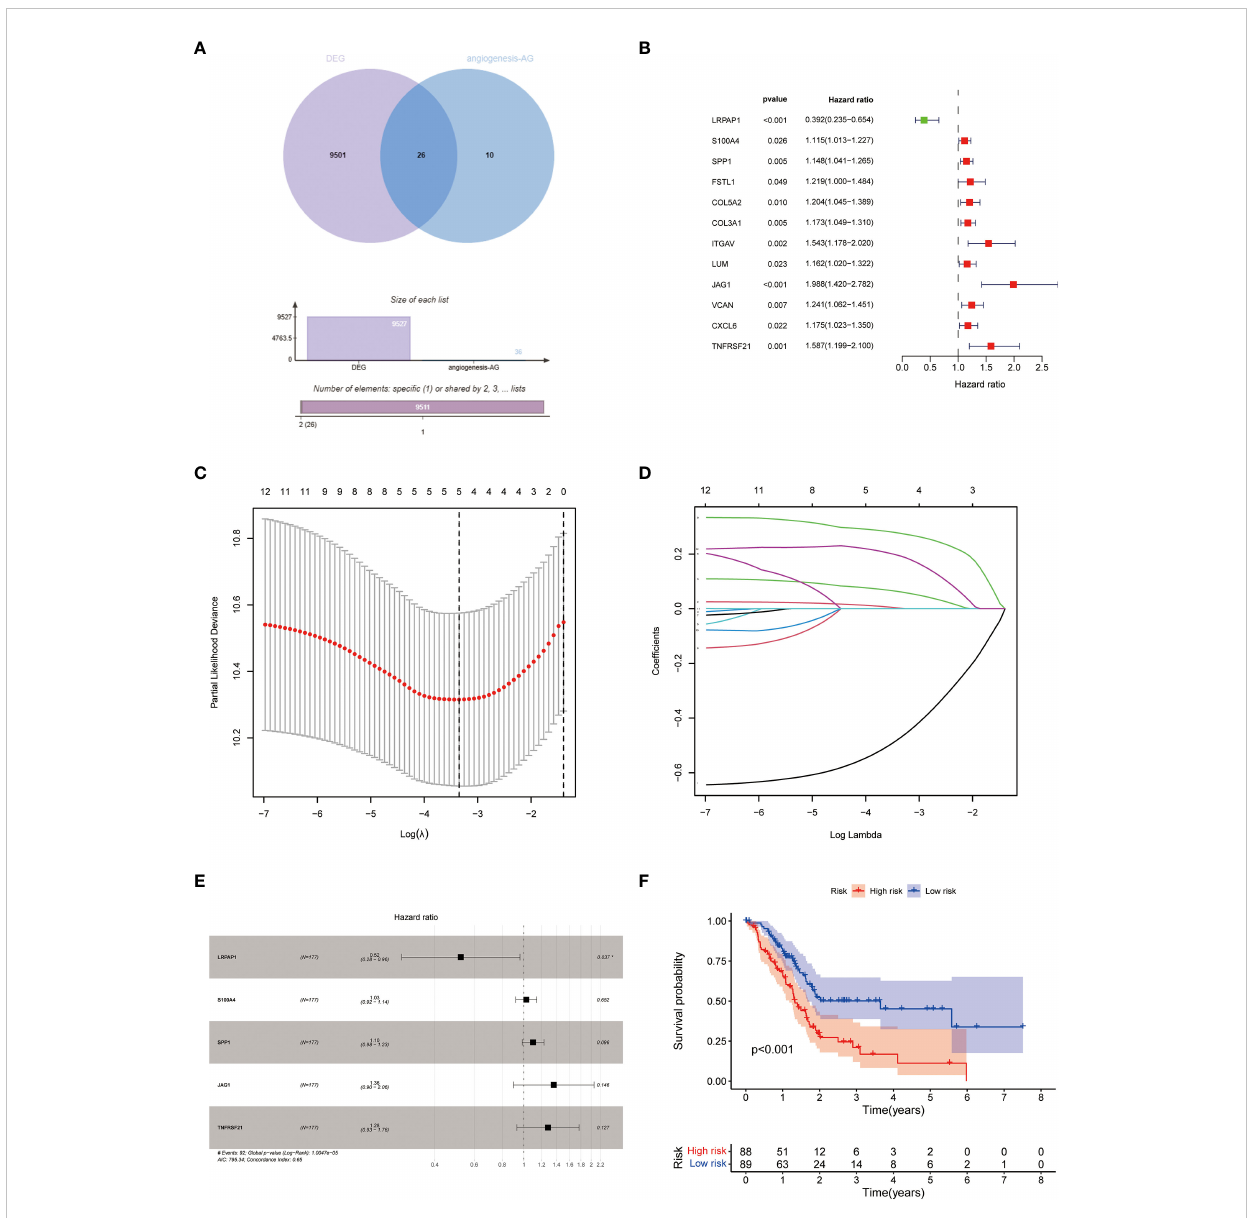
FIGURE 2 Construction of APM. (A) Venn diagram of angiogenesis-related genes and PC DEG; (B – E) Construction of APM using univariate Cox, lasso, and multivariate Cox analyses. (F) KM survival curves of